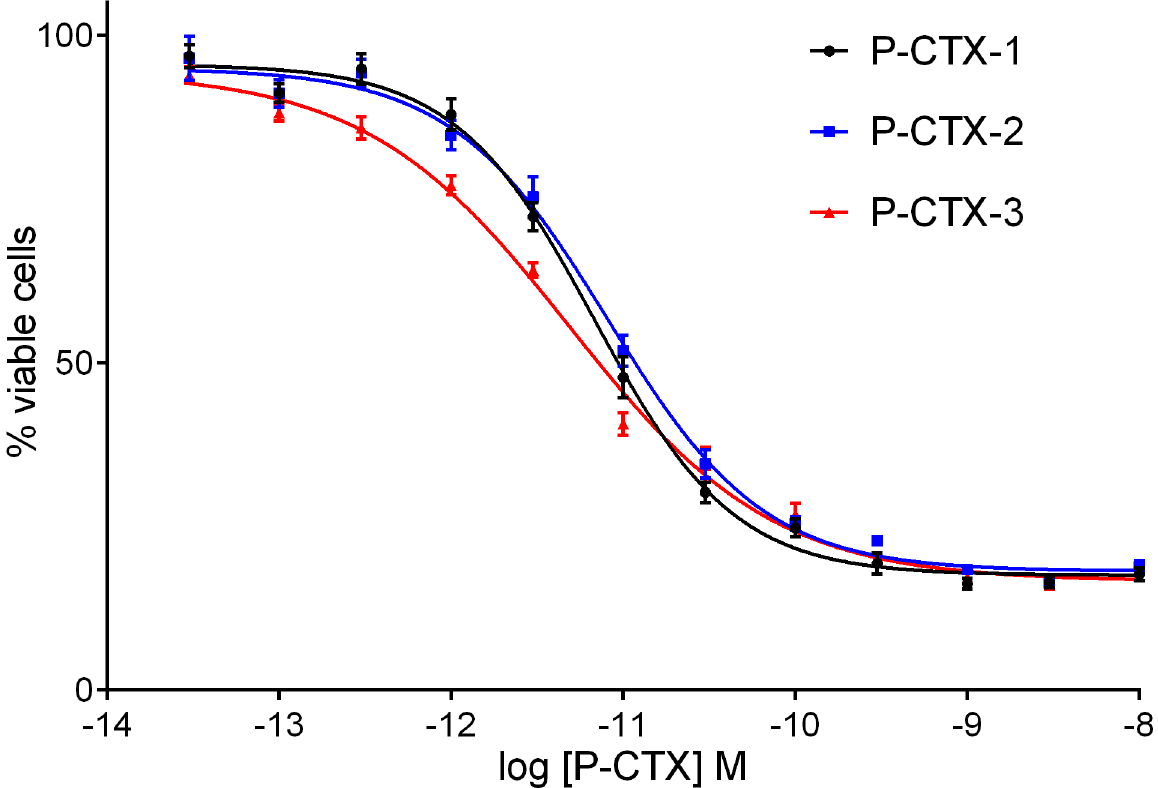
Fig 3. Cell viability assay. Cell death measured in Neuro2a cells treated with veratridine (10 μ M), ouabain (100 μ M) and varying concentrations of Pacific ciguatoxins. The pEC 50 values of P-CTX-1, -2 and -3 were 11.17 ± 0.03, 11.09 ± 0.04 and 11.31 ± 0.04, respectively. Data are presented as value ± standard error (n =